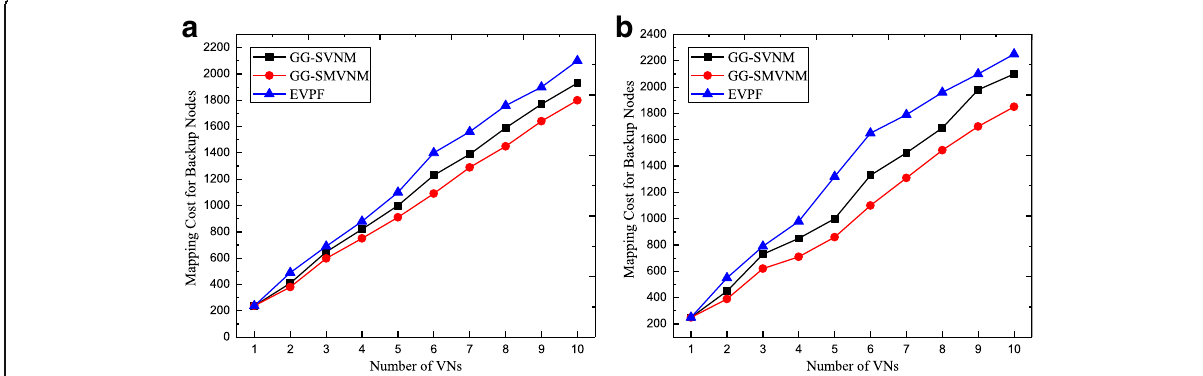
Fig. 8 Mapping costs for backup nodes. a Simulation results on Net-1. b Simulation results on